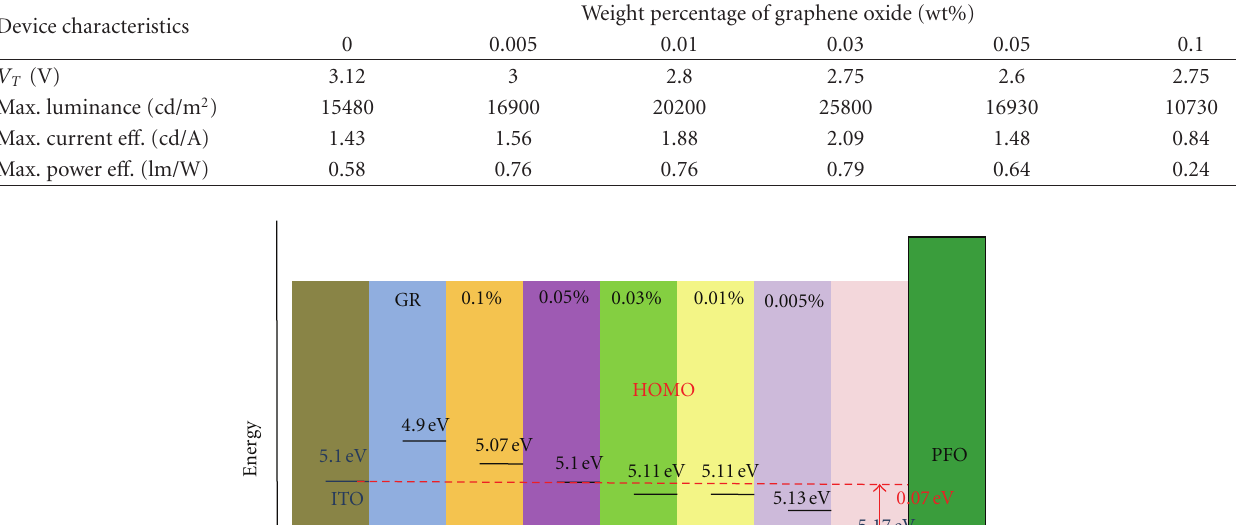
Table 1: Electrical characteristics of the PLEDs with various concentrations of PEDOT:PSS/graphene composite layers. Device characteristics